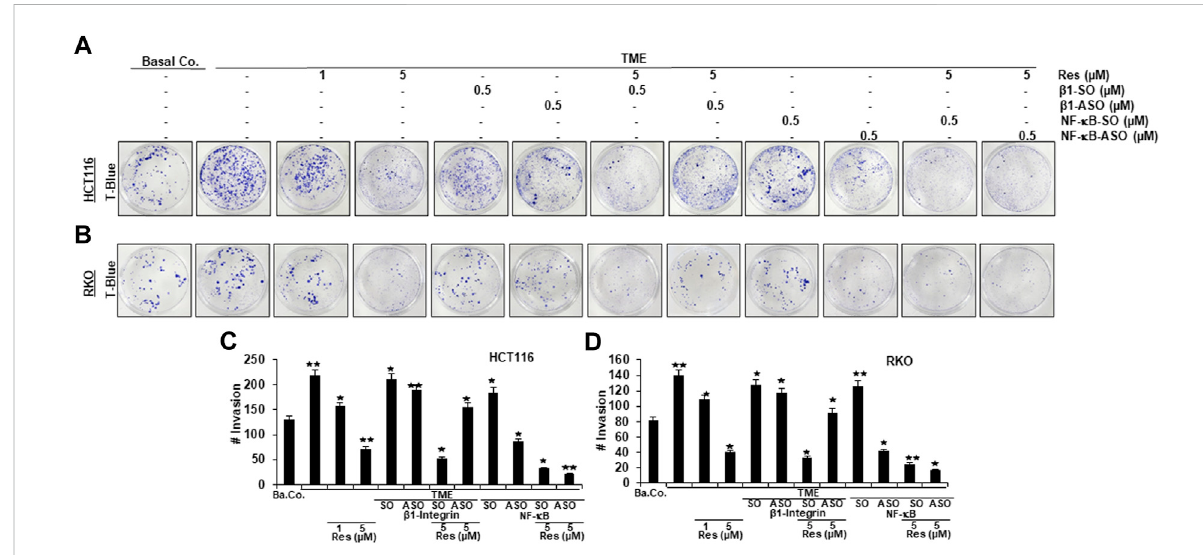
FIGURE 4 Impact of resveratrol or/and ASO against β 1-integrin or against NF- κ B on TME-promoted CRC cell invasion in alginate cultures. Serum-starved HCT116 (A) and RKO (B) cells, cultured in 3D-alginate, emigrated under following treatments: untreated (Basal Co.), TME control, resveratrol (1, 5 µM), β 1-SO/ASO(0.5 µM),NF- κ B-SO/ASO(0.5 µM)orco-treatmentofsenseorantisenseoligonucleotideswithresveratrol(5 µM).CRCcellswere stained with toluidine blue (T-Blue) after settling on the bottom of 12-well-plates. Statistical evaluation: Compared to TME control, * p < 0.05 and ** p < 0.01 for HCT116 (C) and RKO (D)